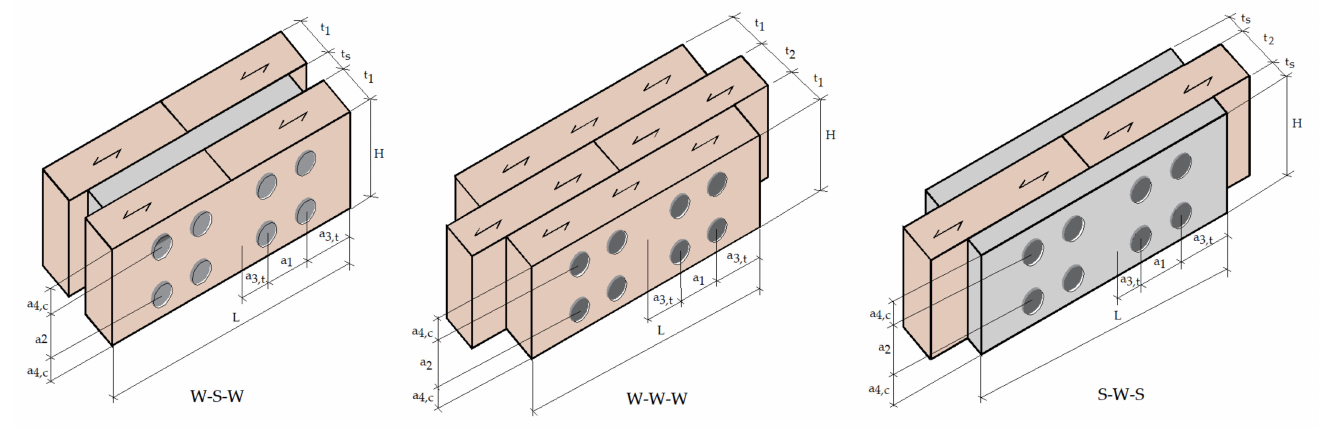
Figure 4. Timber connections in study. Wood grain is parallel to the axial direction.